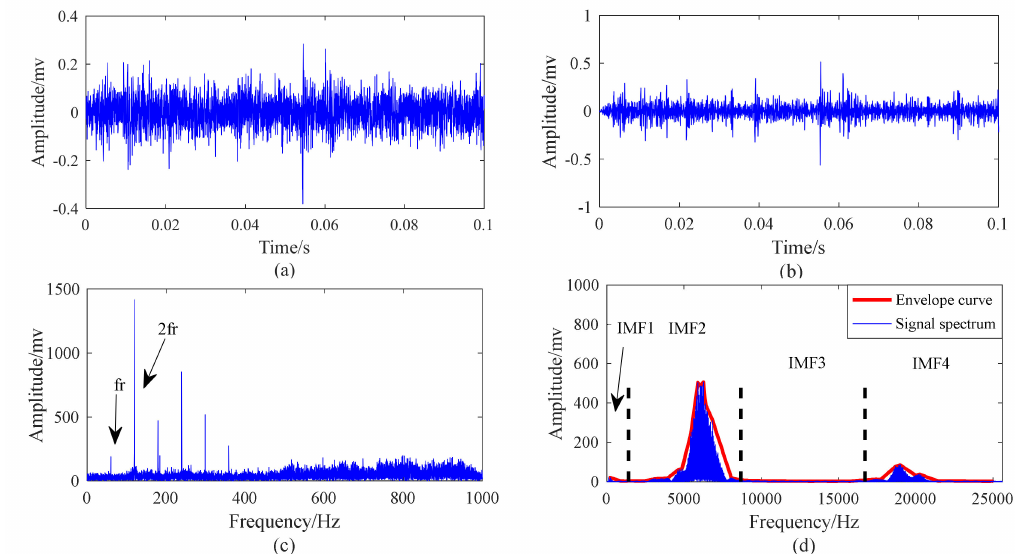
Figure 21. The collected signal of the bearing with 1 mm outer race fault and the result of the collected signal processed by the MCKD-EWT method: ( a ) the original signal; ( b ) the de-noised signal processed by MCKD method; ( c ) the spectrum of the original signal; ( d ) the Fourier spectrum segmentation result of the de-noised signal obtained by Improved EWT